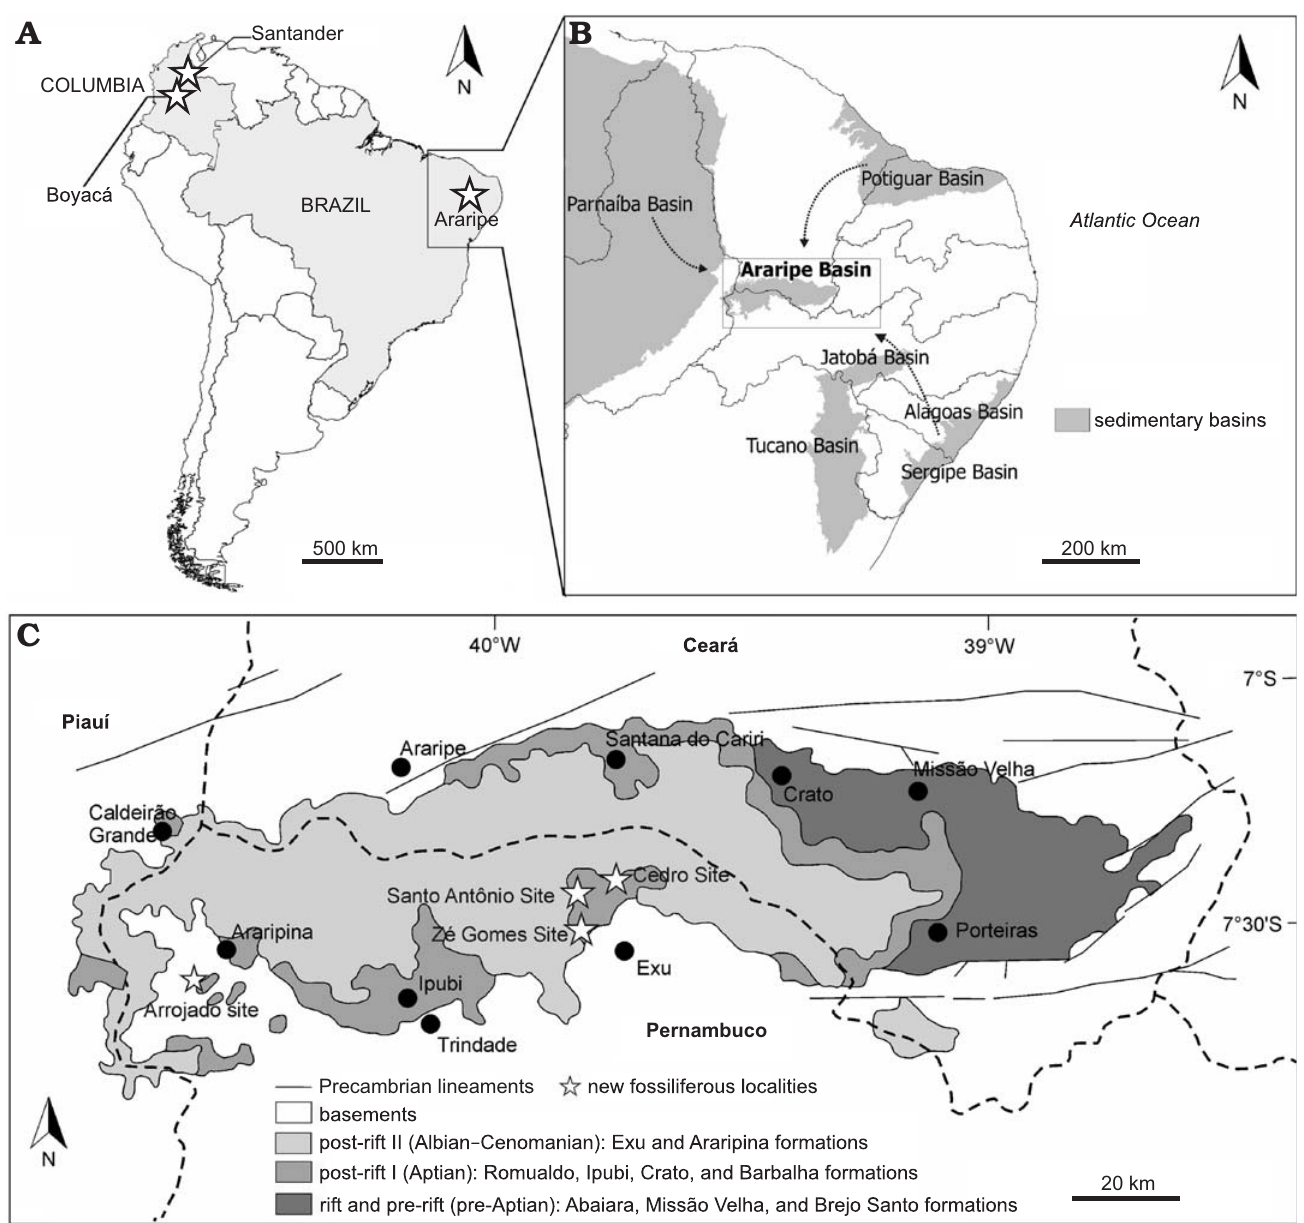
Fig. 1. A . Map showing the known occurrences (stars) of orithopsid and eubrachyuran genera in the Early Cretaceous of South America: upper Aptian– lower Albian San Gil Inferior Formation, Boyacá and upper Aptian Paja Formation, Santander, Colombia and upper Aptian–lower Albian Romualdo Formation, Araripe Basin, Brazil. B . Sedimentary basins of northeast Brazil; arrows show the three possible routes of Cretaceous marine ingression into the Araripe Basin. C . New fossiliferous localities (stars) with brachyuran crabs from upper Aptian–lower Albian Romualdo Formation, Araripe Basin, Pernambuco, Brazil (base map modified from Assine